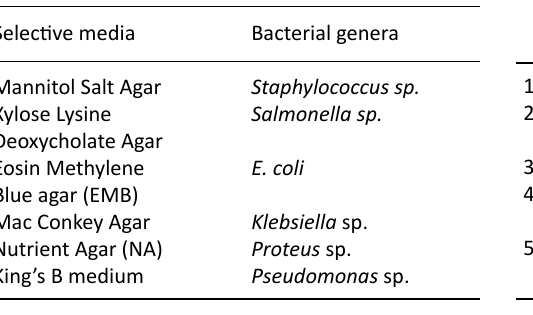
Table 1. Selective medium for isolation of pathogens Selective media Bacterial genera Mannitol Salt Agar Staphylococcus